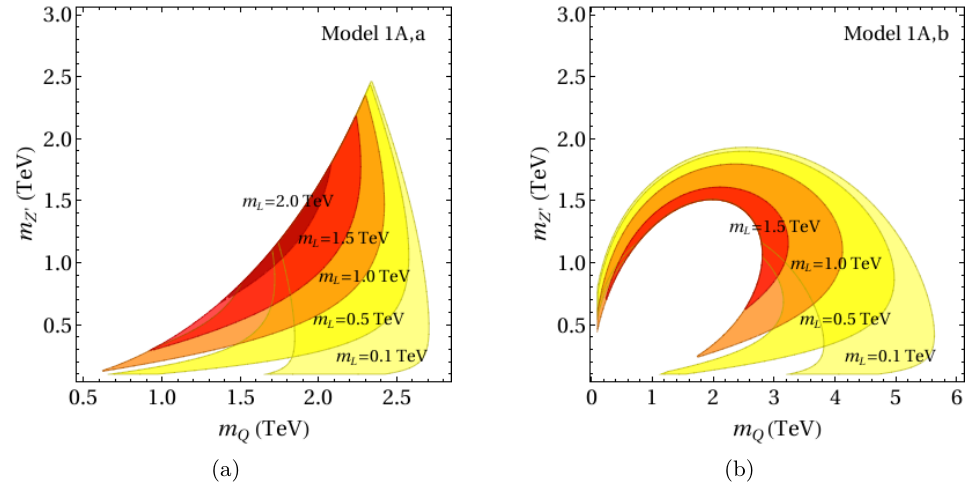
Figure 4 . (a) The parameter space of Model 1A , a allowed by the flavor anomalies and the constraints from B -meson mixing and neutrino trident production in the ( m s the parameter space corresponding to selected choices of m